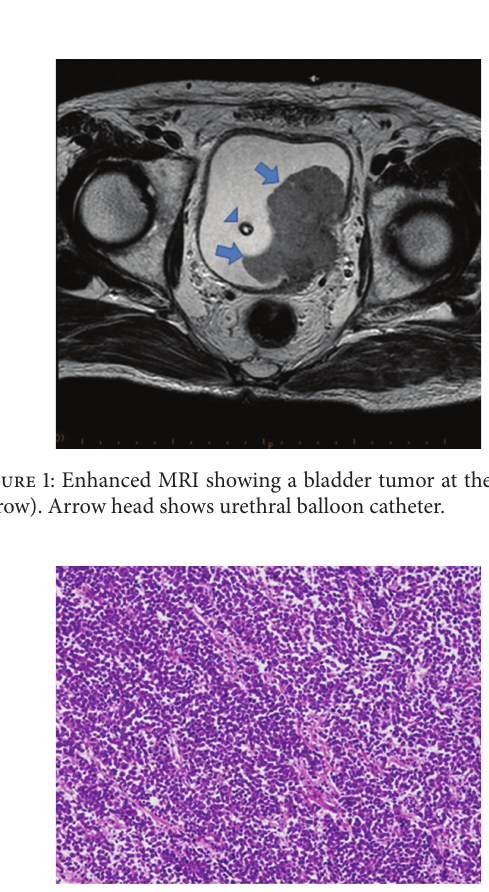
Figure 2: Histopathological examination of small cell carcinoma of the urinary bladder with H & E staining ( × 100). Tumor cells are characterized by a high nuclear to cytoplasmic ratio.